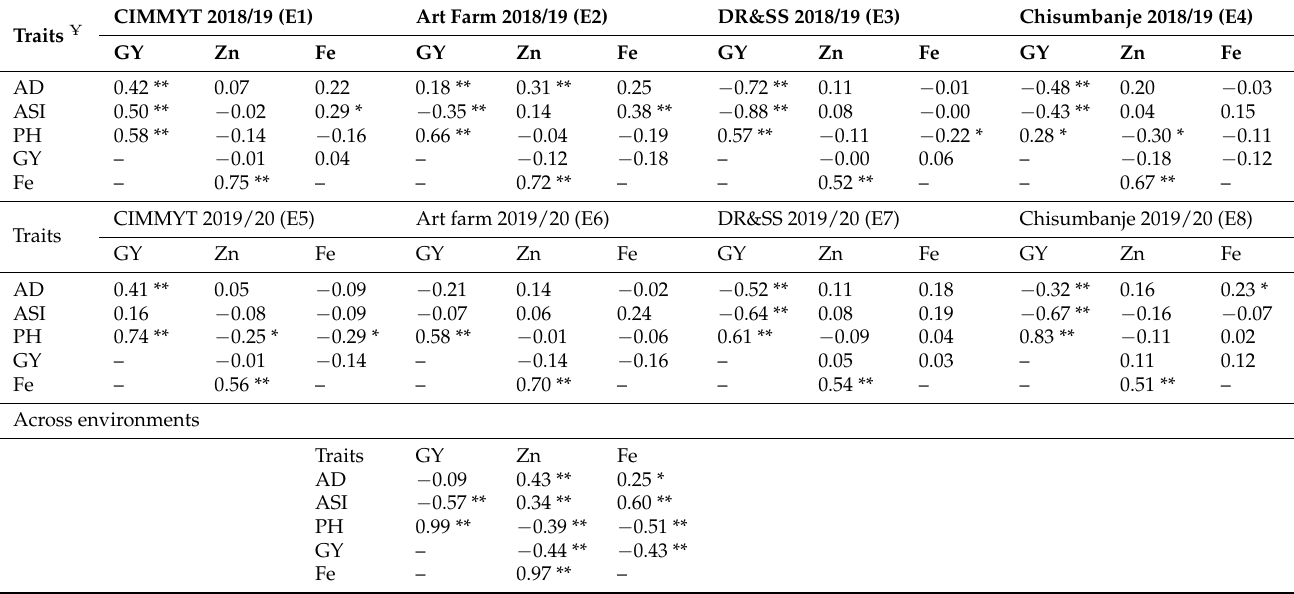
Table 5. Correlation of grain Zn and Fe concentrations with agronomic traits in Zn-enhanced hybrids. Traits